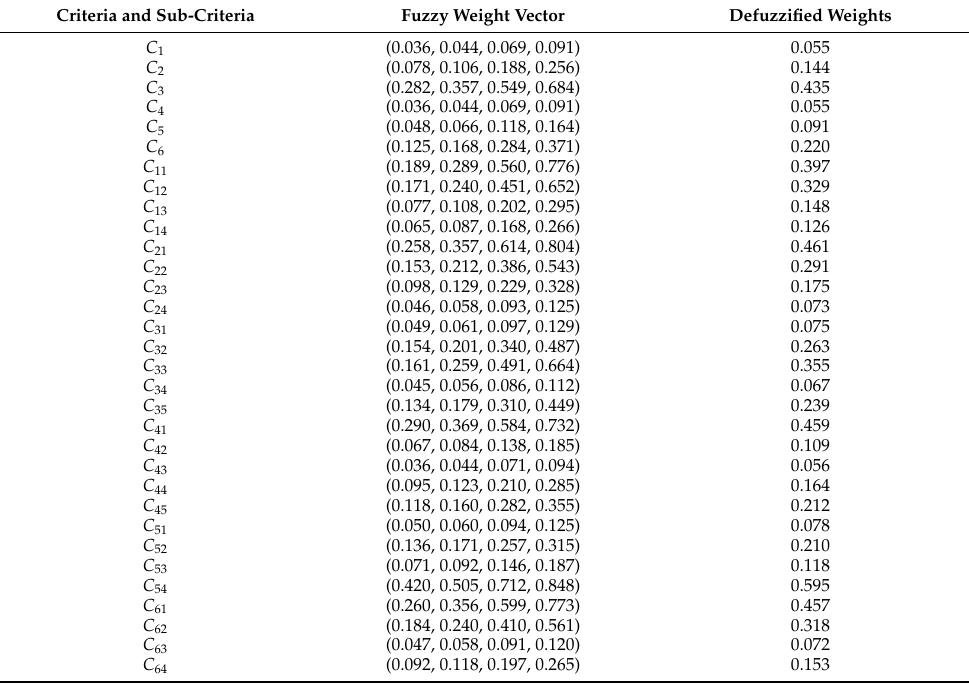
Table 5. The weights of the criteria and sub-criteria. Criteria and